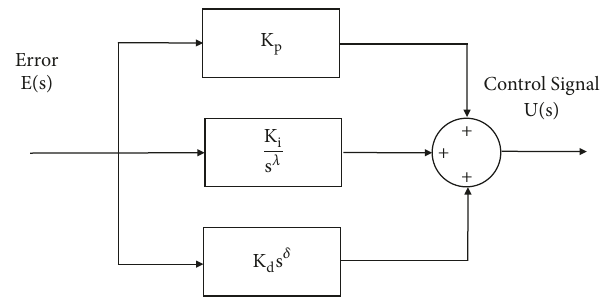
Figure 5: PI 𝜆 D 𝛿 controller (parallel general